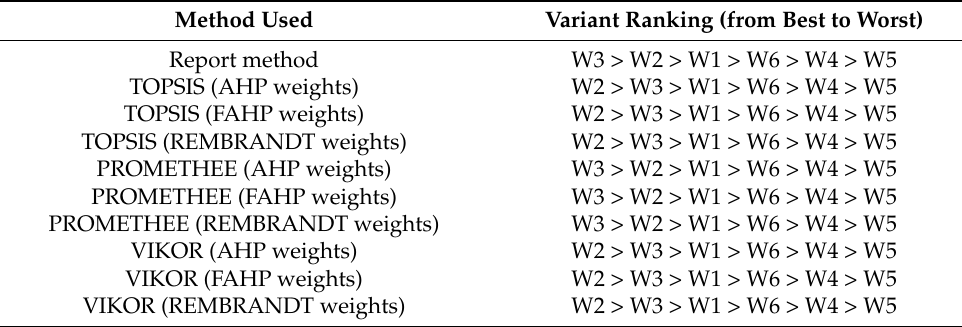
Table 13. Ranking of decision variants: summary list.